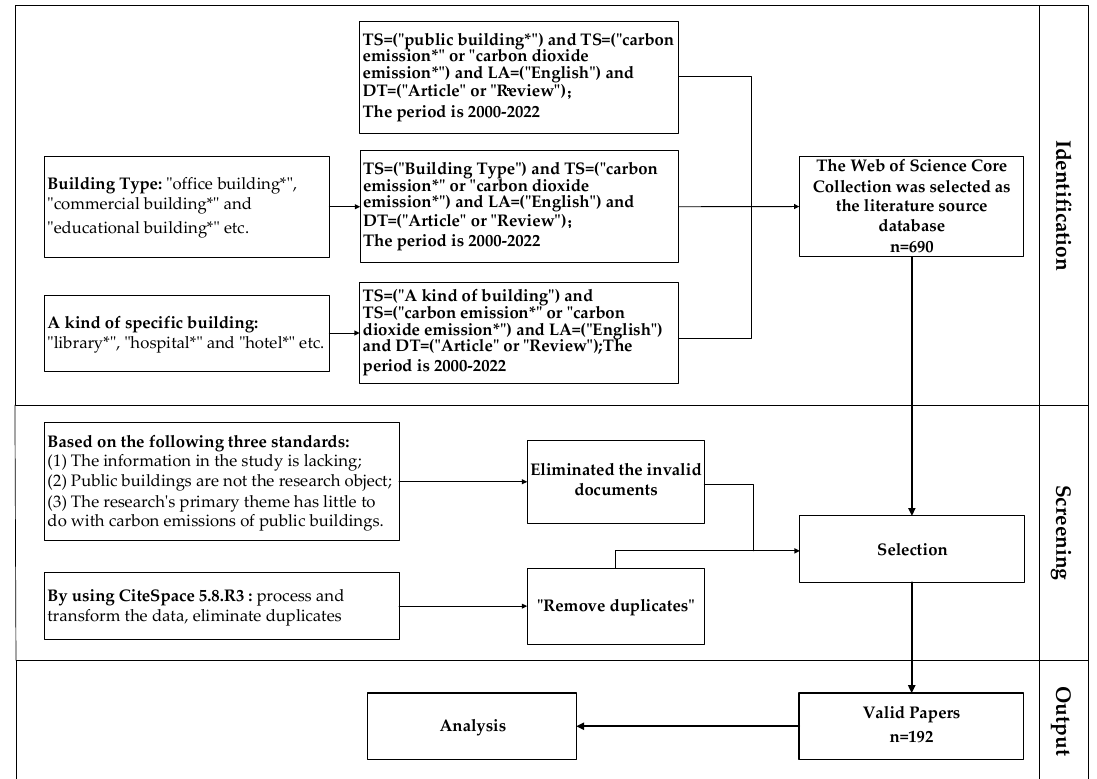
Figure 1. Data collection